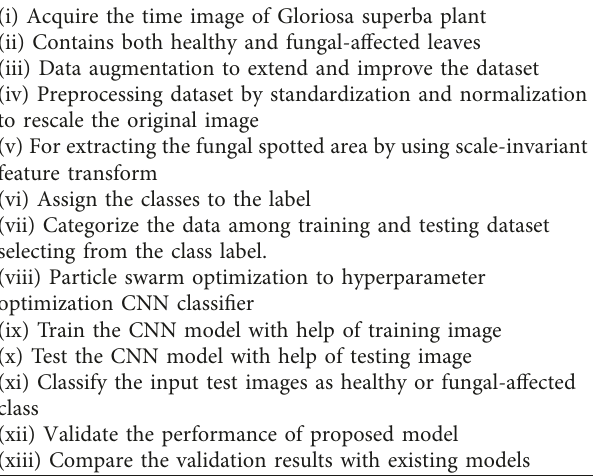
Table 1: Algorithm for the proposed